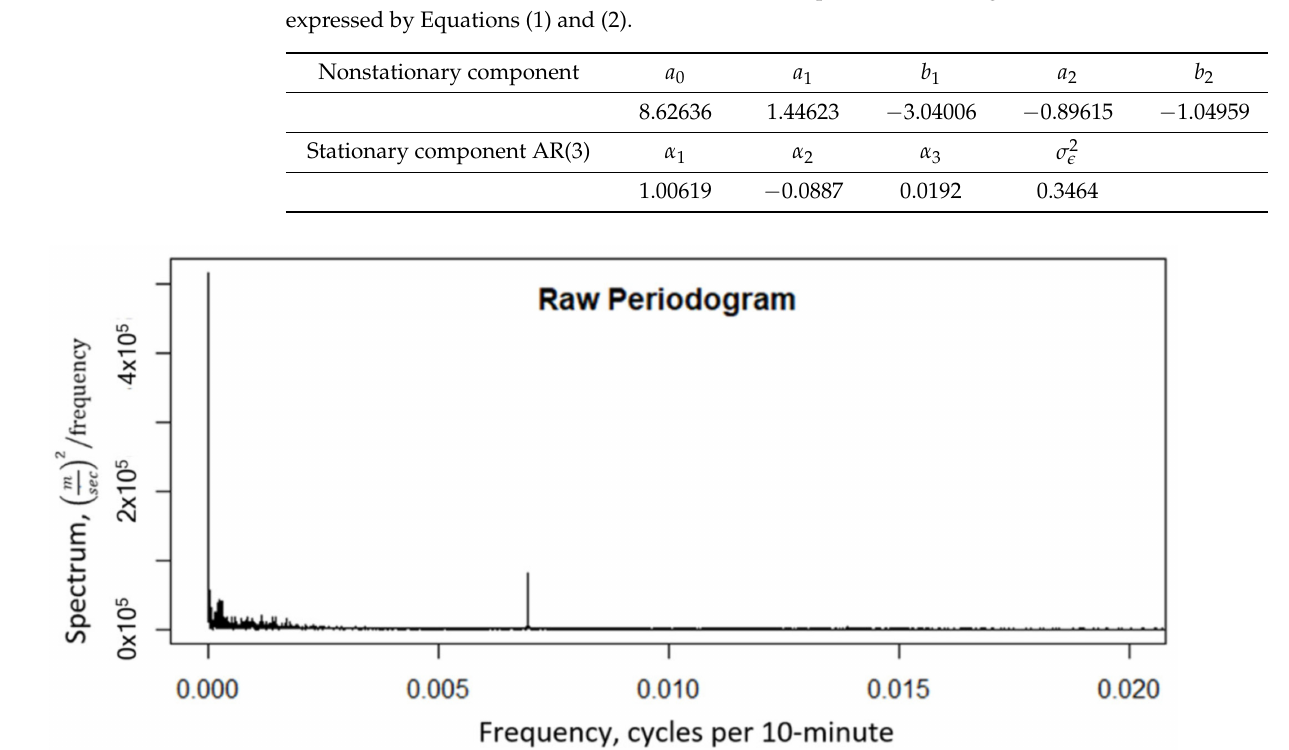
Figure 6. The periodogram of 10 min average wind speed at 100 m height.